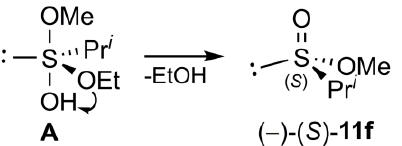
8 of 15 Scheme 8. Structures of the reactive complex B(H 2 O) 2 , transition state TS1(H 2 O) 2 , and product complex PC1(H 2 O) 2 of the (H 2 O) 2 -mediated substitution of OEt by OH in (+)-( R ) -8b ; the substitu-